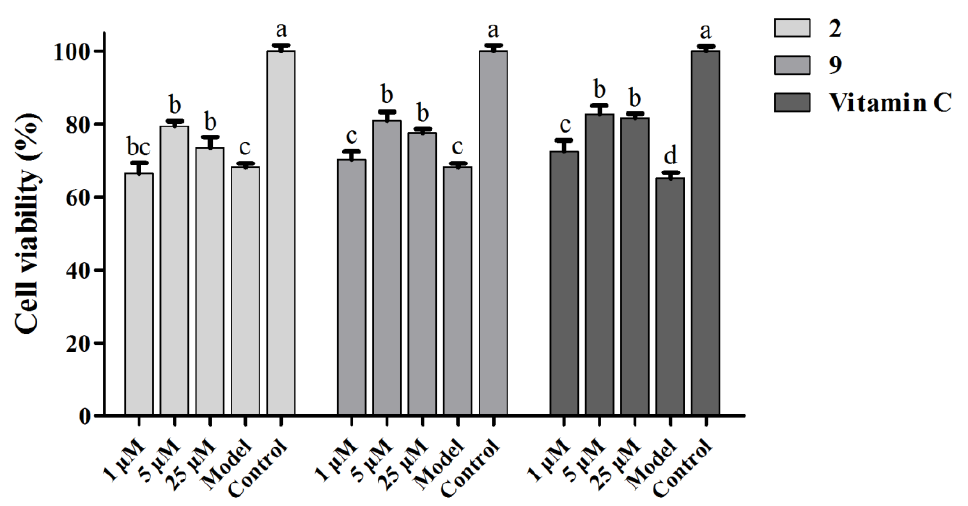
Figure 8. Protective effects of compounds 2 and 9 on H 2 O 2 -induced injury in L02 cells. Vitamin C was used as positive control. Data are expressed as means ± SD ( n = 3), and means labeled with different letters (a – c) are significantly differ- ent at a level of p < 0.05 ( n = 3) by one-way ANOVA DMRT.